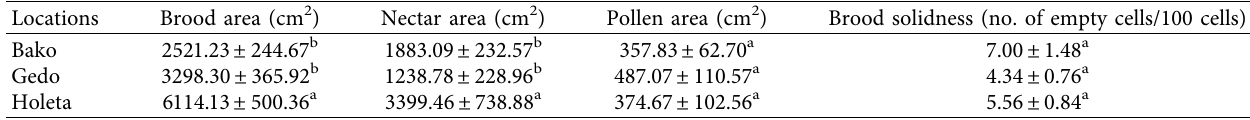
Table 1: Brood, nectar, pollen area, and brood solidness of honeybee populations of diferent altitudes (mean ± SE).